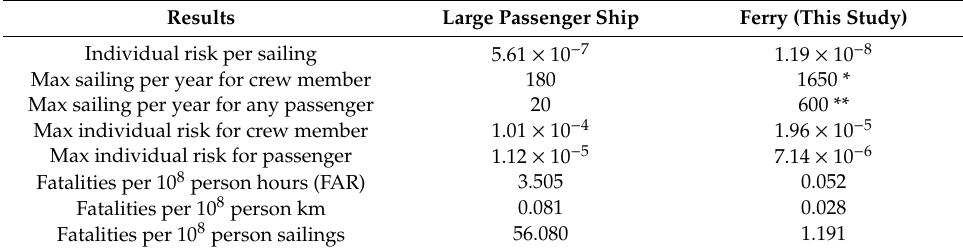
Table 17. Results comparison for all passenger ship and high-speed battery-driven